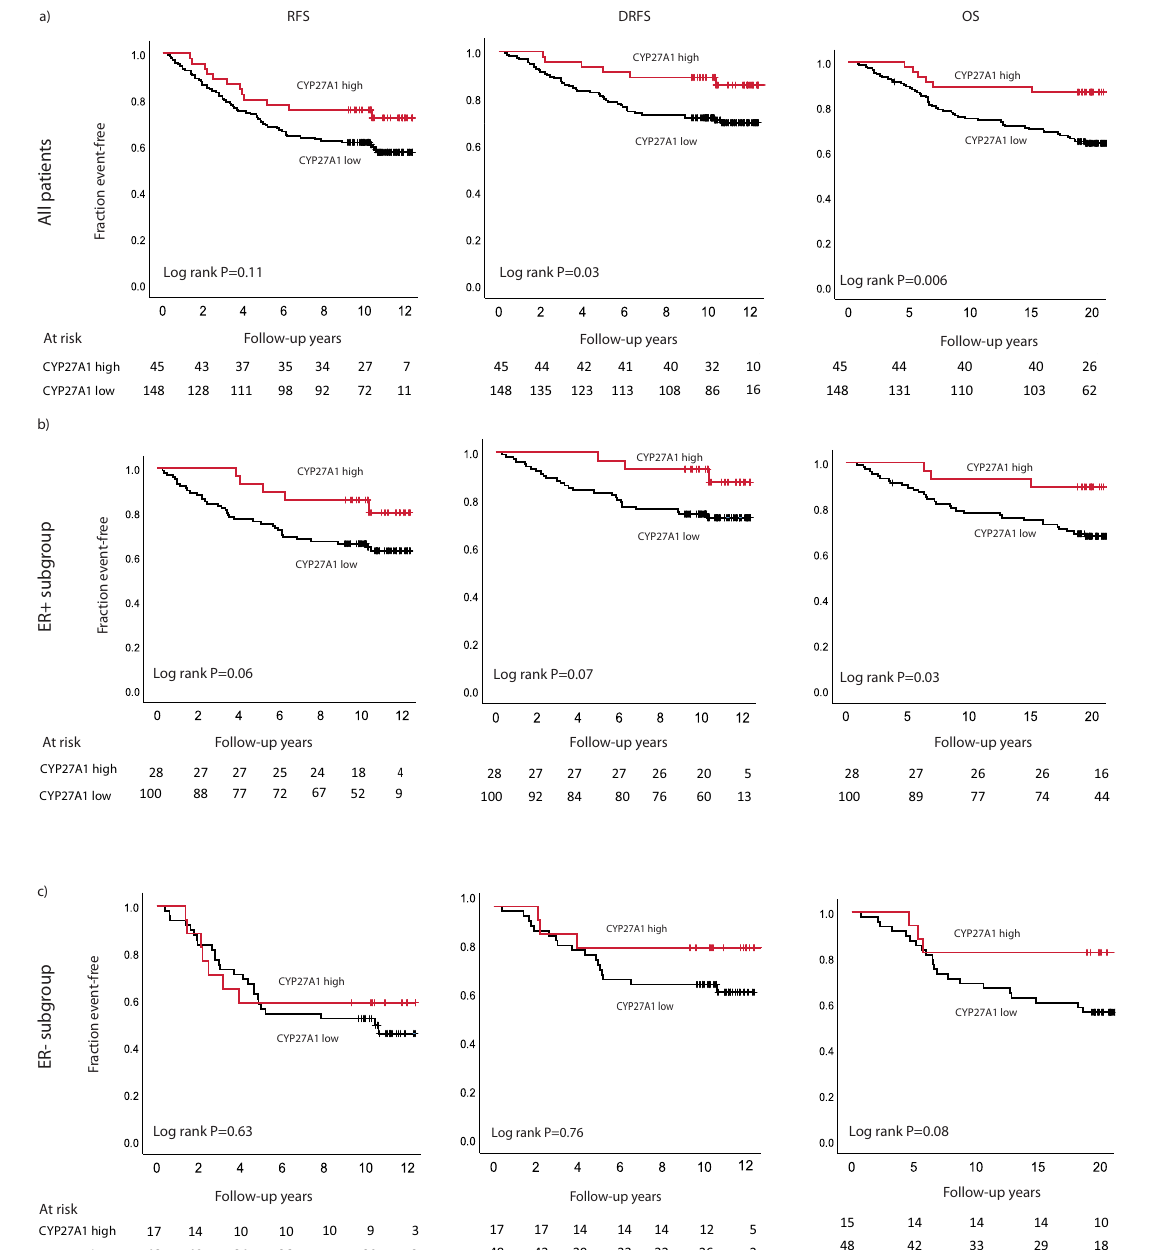
Fig. 2 Kaplan – Meier graphs showing associations between CYP27A1 mRNA expression and survival. a All patients, b subset of patients with ER + tumors, and c ER –